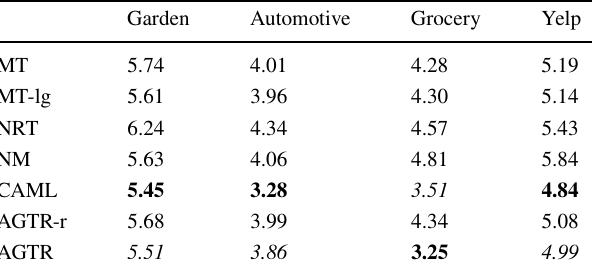
Table 5 Review generation performance in terms of Perplexity